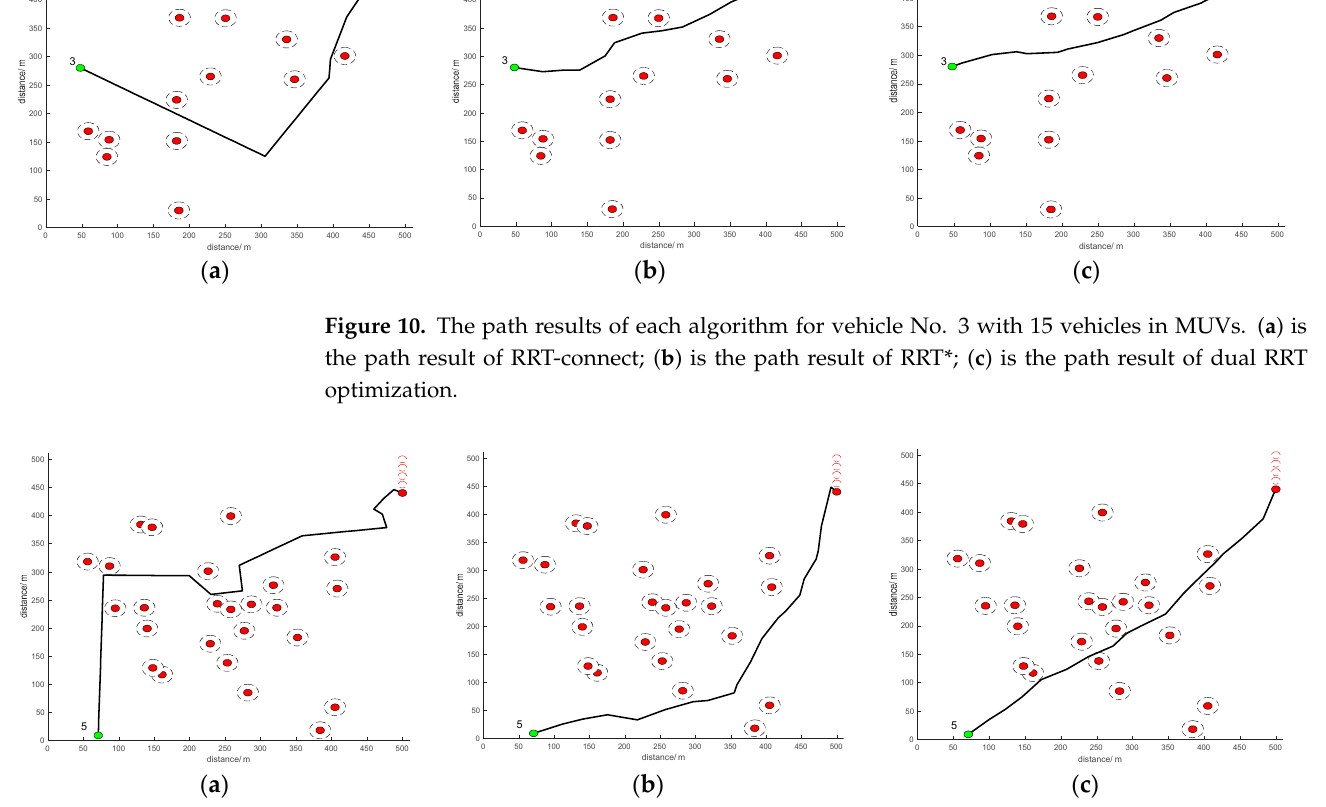
Figure 11. The path results of each algorithm for vehicle No. 5 with 30 vehicles in MUVs. ( a ) is the